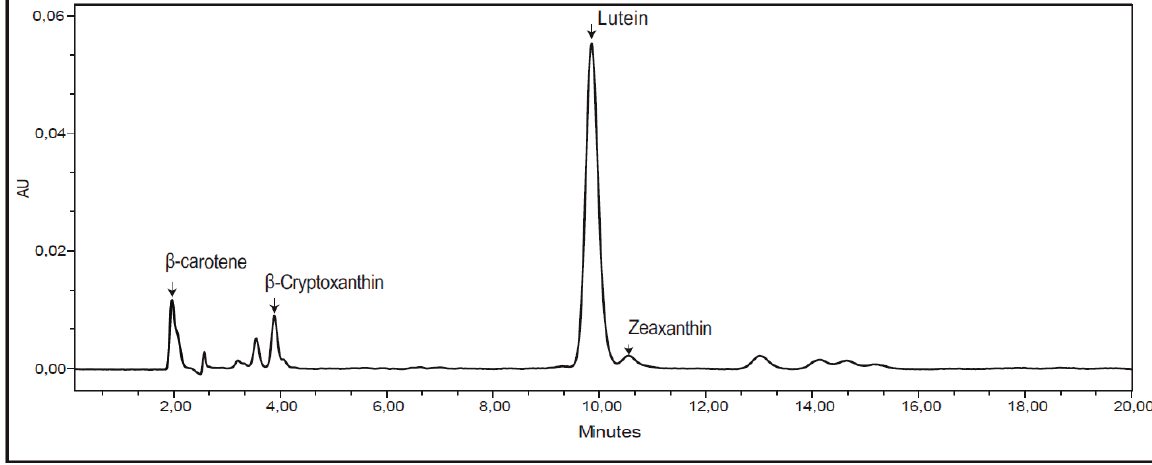
Figure 1. Representative chromatogram of the genotype Öland